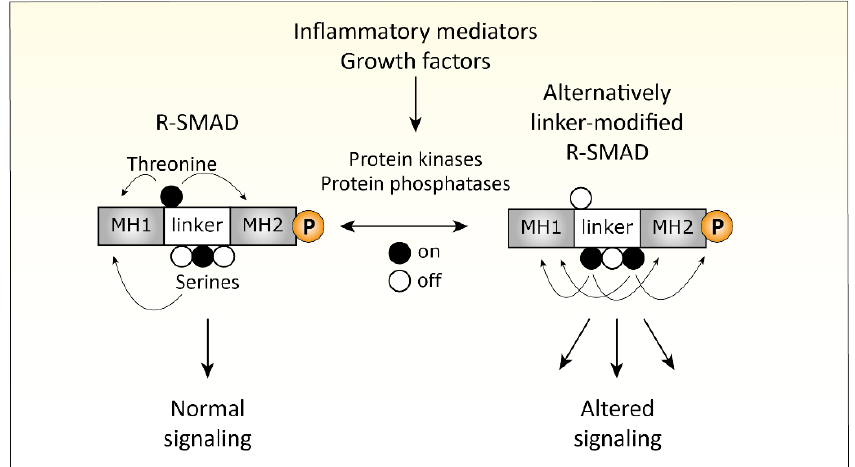
Figure 5. SMAD linker modifications alter Transforming growth factor β (TGF β ) signaling. The SMAD proteins consist of a MH1 and MH2 domain, connected with a non-conserved linker domain. Threonine and serine residues in the linker domain can be modulated by protein kinases and phosphatases like mitogen-activated protein kinases (MAPKs), c-Jun N-terminal kinases (JNK), and Glycogen synthase kinase 3 (GSK-3). These kinases can be activated by growth factors and inflammatory mediators. This process greatly affects SMAD function and leads to altered TGF β signaling.